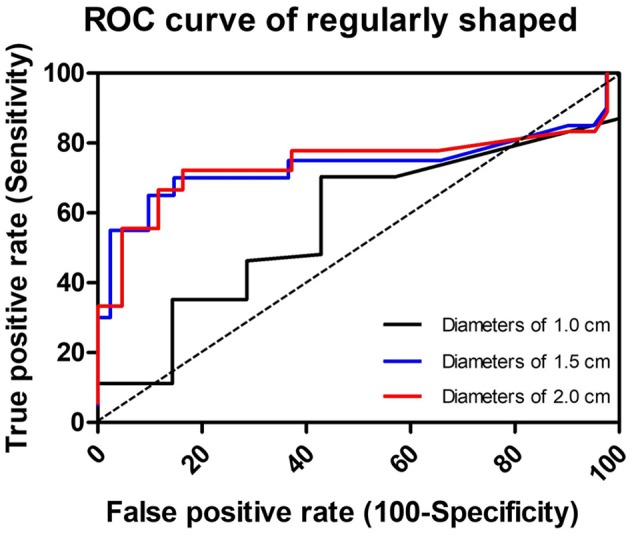
Receiver-operator characteristic curve (ROC) to illustrate the three cutoff diameters as predictors of slow transit in regularly shaped foreign bodies. The dotted line in the diagonal present the ROC curve of a random predictor (AUC: 0.5).